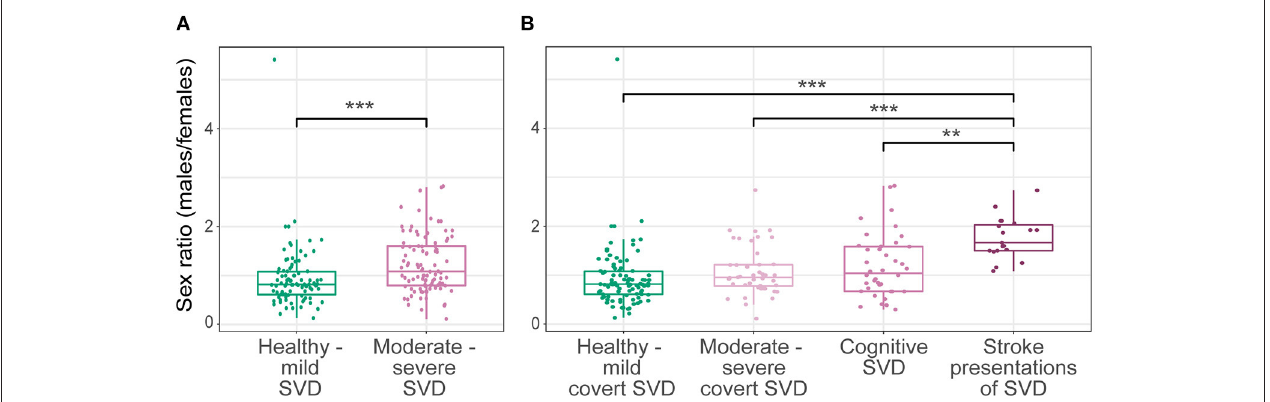
FIGURE 4 | Sex ratio across SVD severity and presentation. Sex ratio of healthy to mild SVD compared with (A) moderate to severe SVD and (B) stratified moderate to severe SVD. Significant differences were found between SVD severity groups i.e., sex ratios of healthy to mild SVD and moderate to severe SVD (A; U = 3,031, p < 0.001). Significant differences were also found between SVD presentation groups (H = 36.58, df = 3, p < 0.001) i.e., stroke presentations of SVD compared with healthy to mild covert SVD, moderate to severe covert SVD or cognitive SVD (B; p corrected < 0.001, p corrected < 0.001, p corrected = 0.003, respectively). ** p < 0.01, *** p <